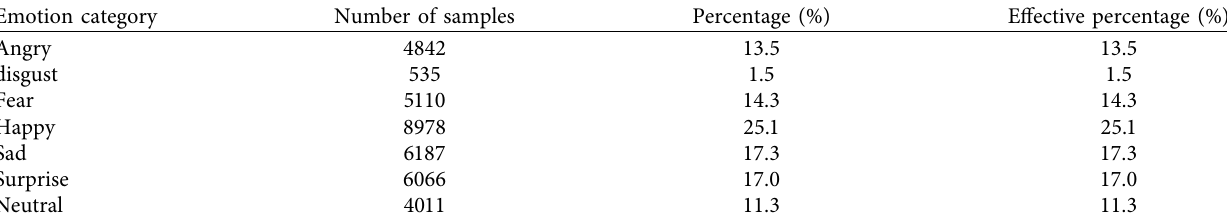
Table 2: FER2013 database situation.